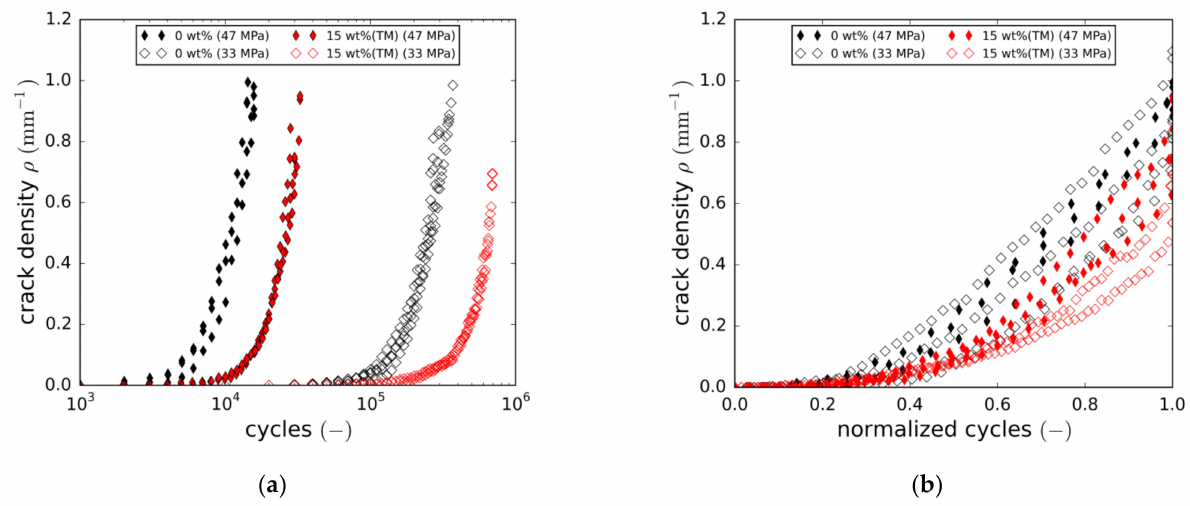
Figure 12. ( a ) Crack density vs. number of cycles, crack density averaged over both cracking directions; ( b ) Crack density vs. number of normalised cycles, crack density averaged over both cracking directions.